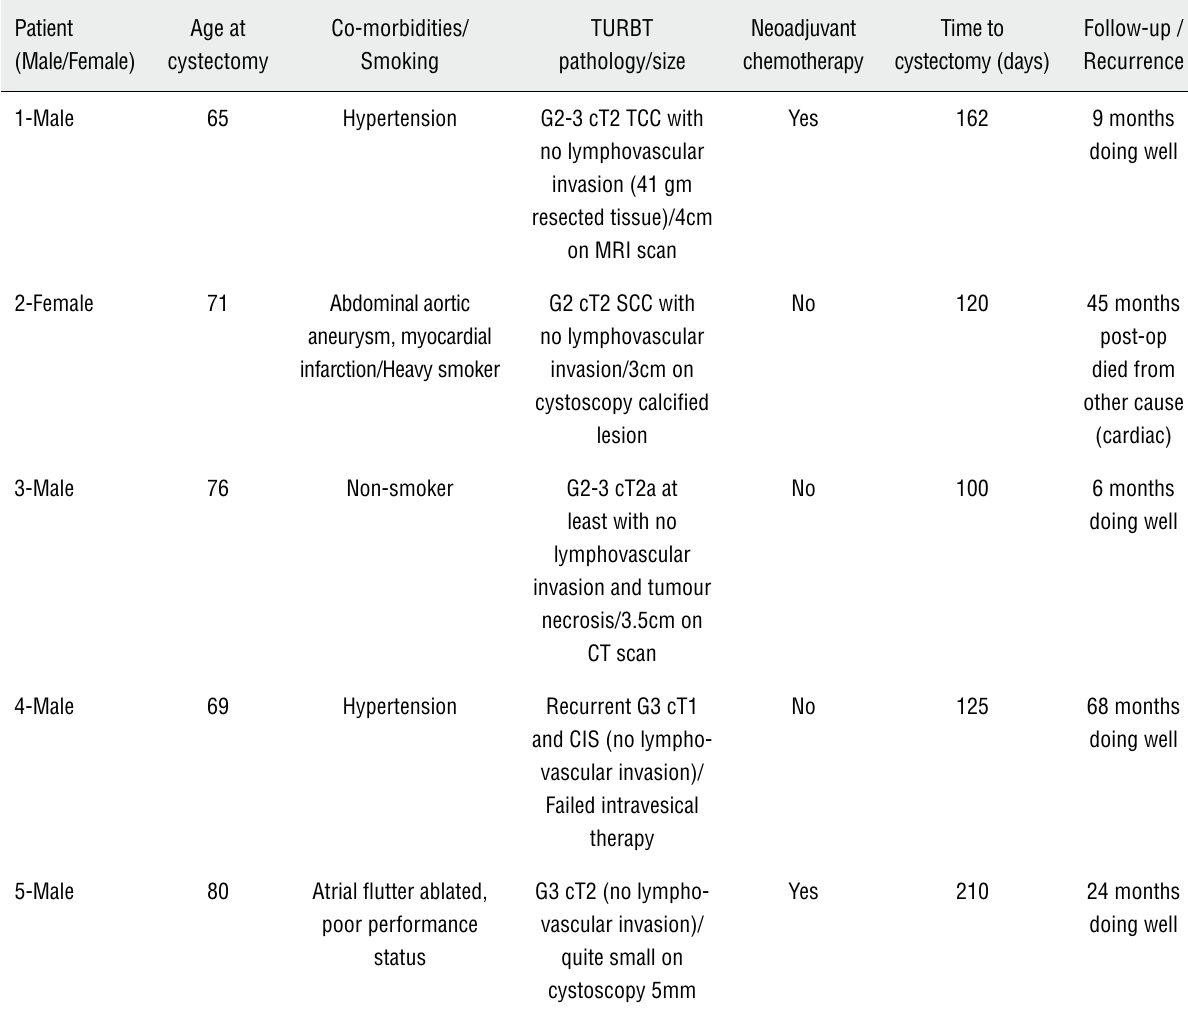
Table 1 - Our series of pT0 radical